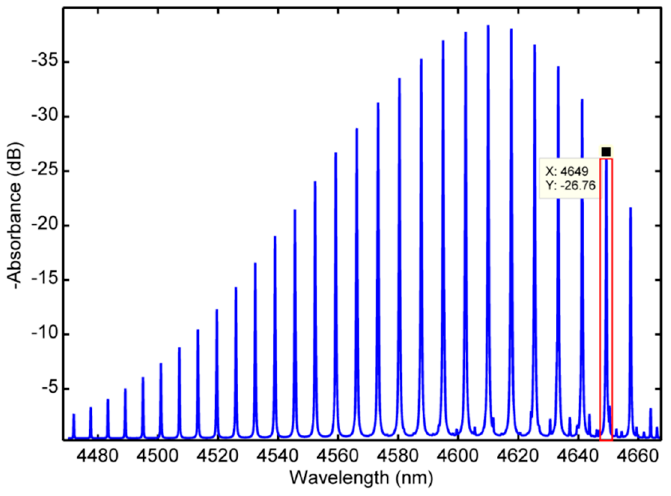
Figure 1. Absorption spectrum of CO